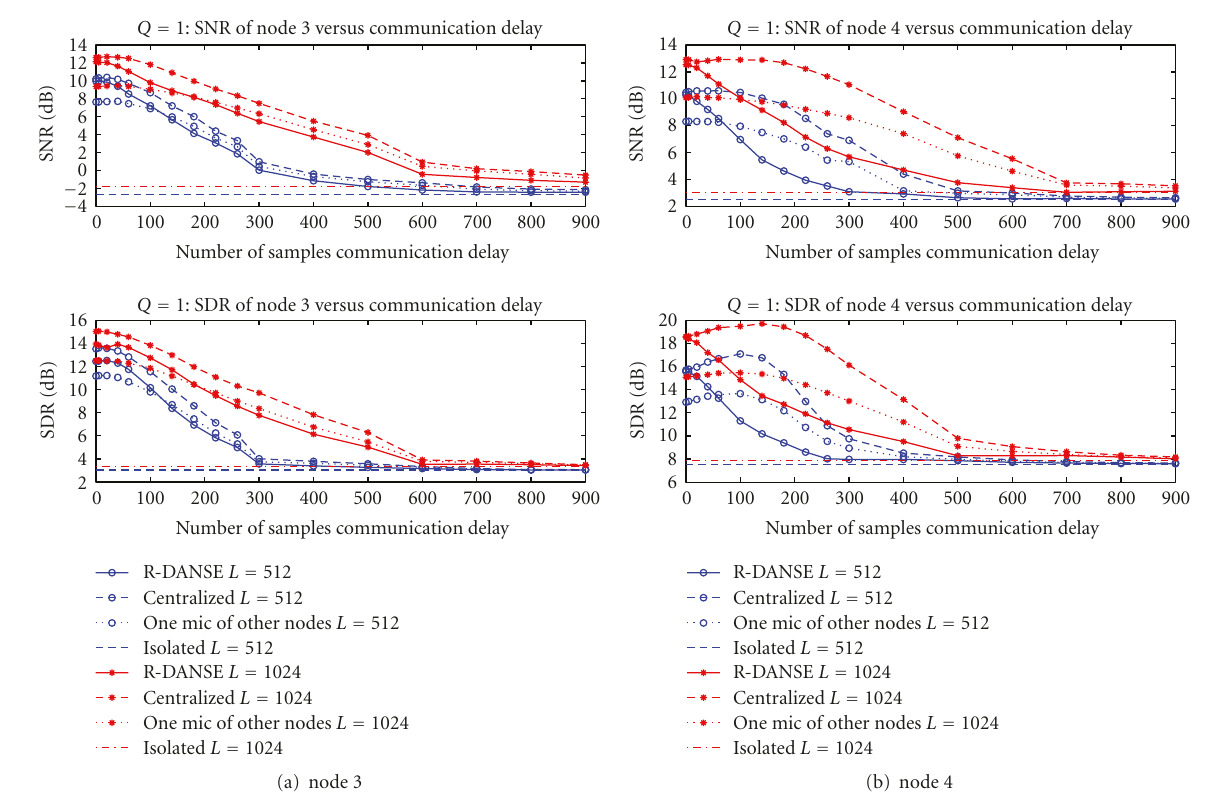
Figure 10: Output SNR and SDR at nodes 3 and 4 after 12 iterations of R-DANSE 1 with sequential updating vs. delay of the communication